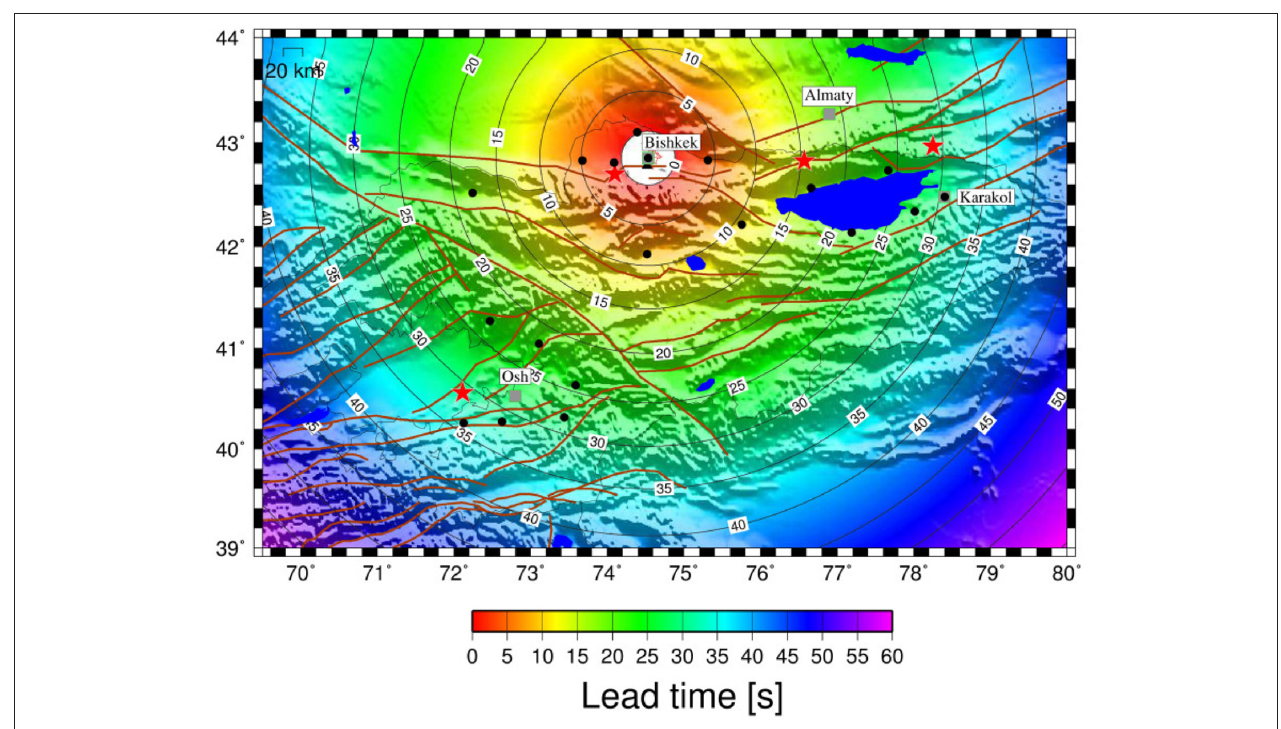
FIGURE 6 | As in Figure 5 , but for an on-site approach.